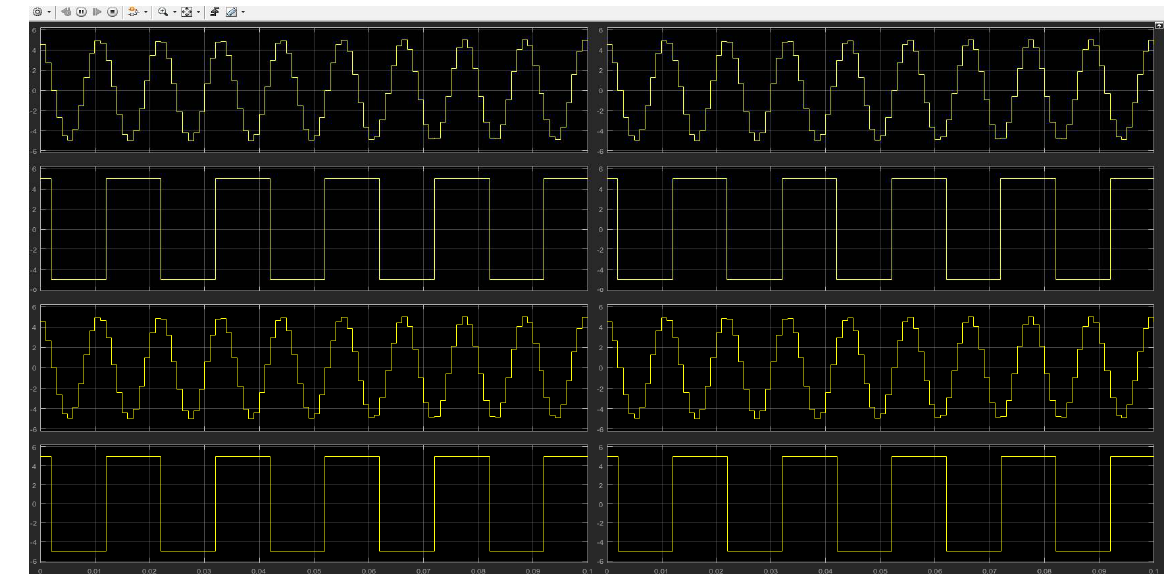
Figure 14. Input and output analog channels signals in OPAL-RT.